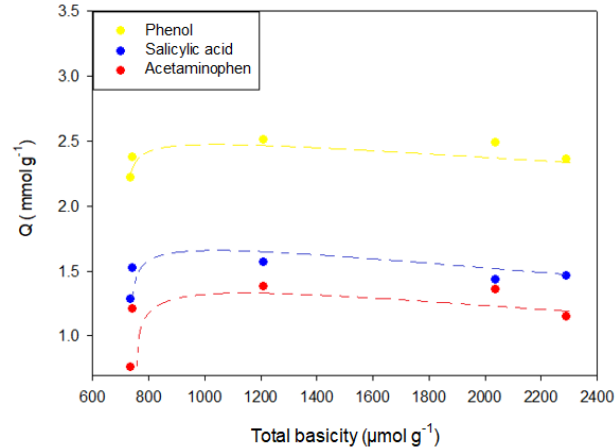
Figure 10. Relationship between the adsorption capacity and the number of basic groups in the adsorption process of phenol, salicylic acid, and acetaminophen on the activated carbons CAO, CAG, CAR1073, CAR1173, and CAR1273.